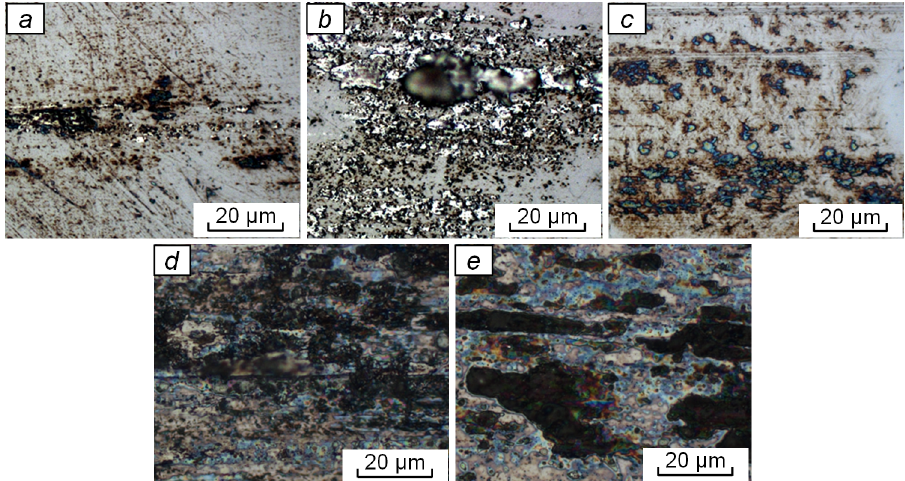
Figure 10. Images of the transferred layer on the steel counterbody after frictional interaction with the ECAP-ed Al-30Sn sample. Sliding distance: ( a )—2 m; ( b )—5 m; ( c )—20 m; ( d )—50 m; ( e )—500 m. Dark phase is aluminum; P = 1 MPa; V sl = 0.07 m/s.